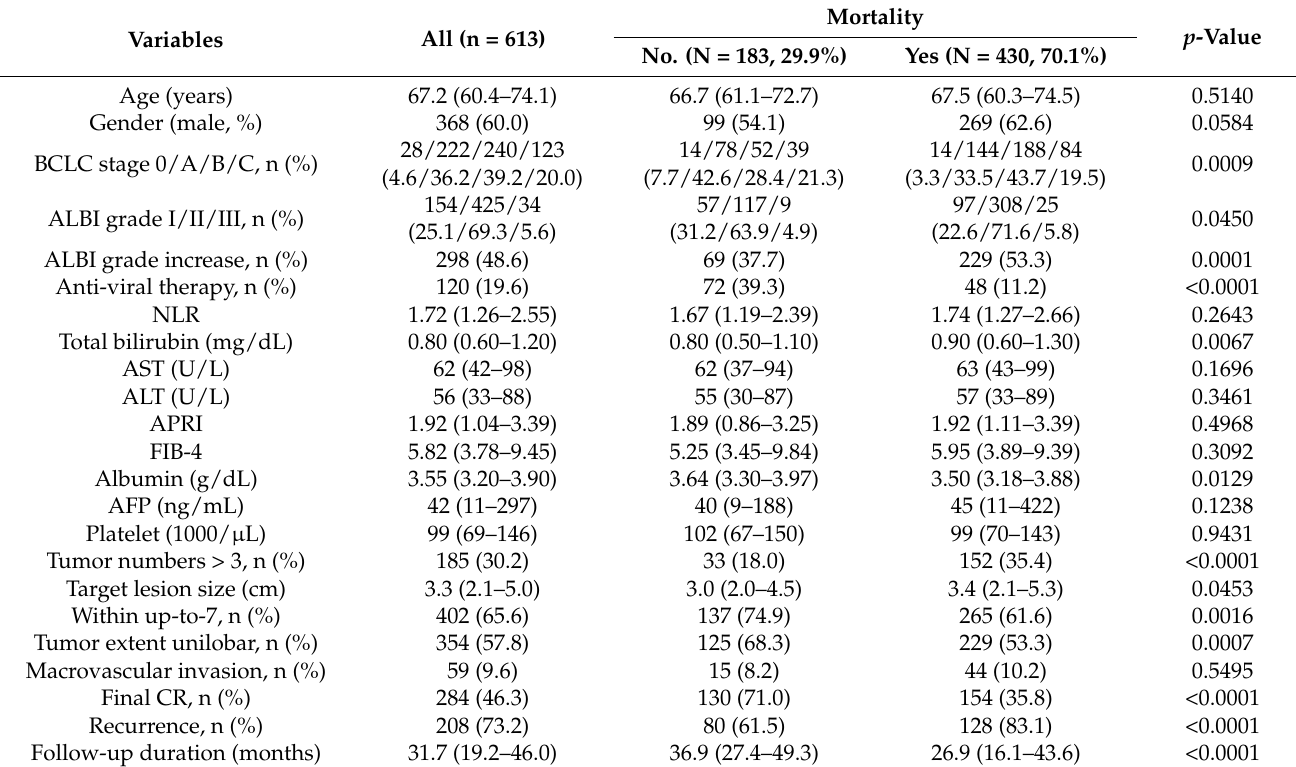
Table 1. Baseline clinical characteristics of patients with overall mortality vs.